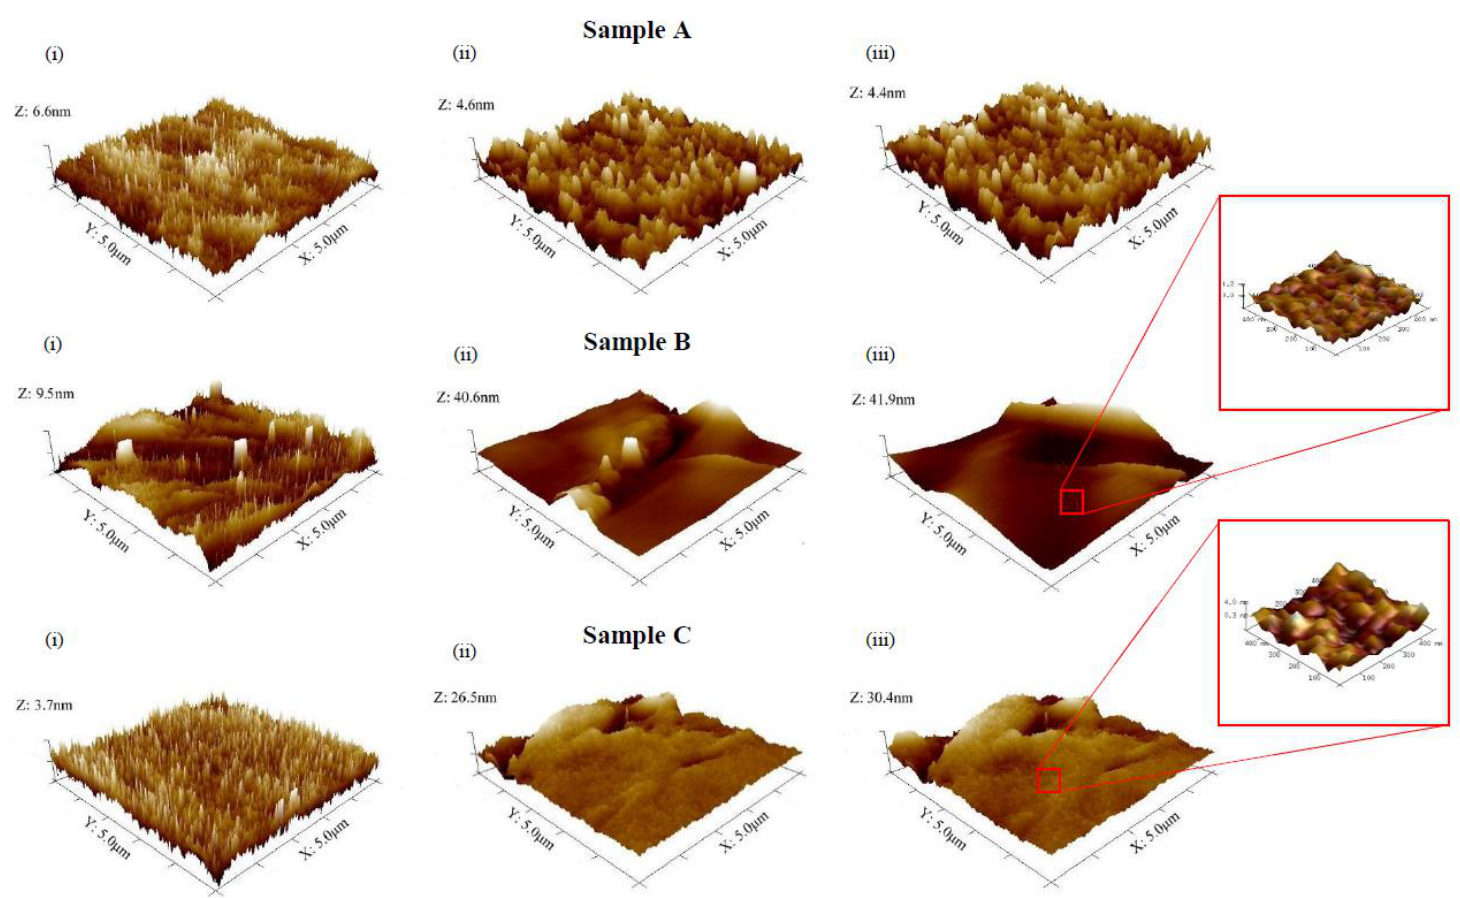
Figure 2. In-situ AFM three-dimensional topography images of high carbon martensitic steel surface at ( i ) 0 min; ( ii ) 60 min; and ( iii ) 105 min, the exposure to 0.1 M NaCl solution.